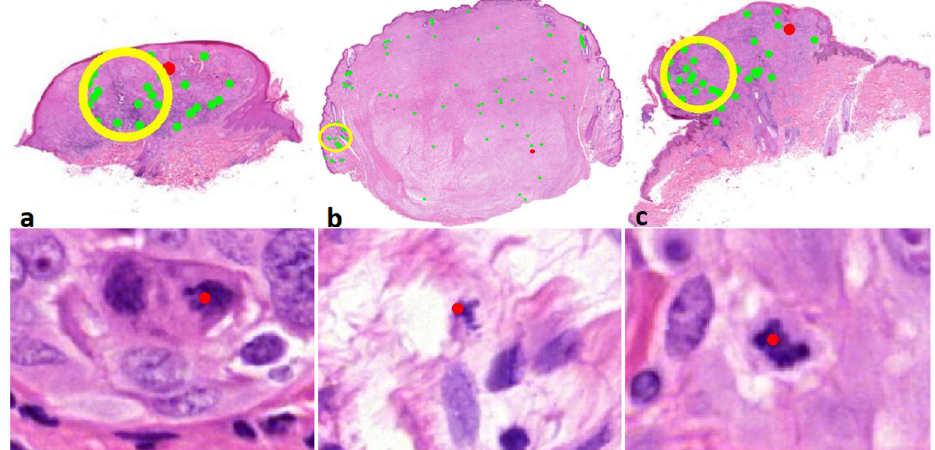
Figure 4. (row above ×6, row below ×800 magnification). Correct dermal mitosis discordant with the consensus. Above overview with red indicates mitosis, below a detailed view of the indicated mitosis. ( a ) Case 56; melanocytoma/intermediate lesion, high risk. ( b ) Case 73; desmoplastic mela- noma . ( c ) Case 100; melanocytoma/intermediate lesion, low risk.